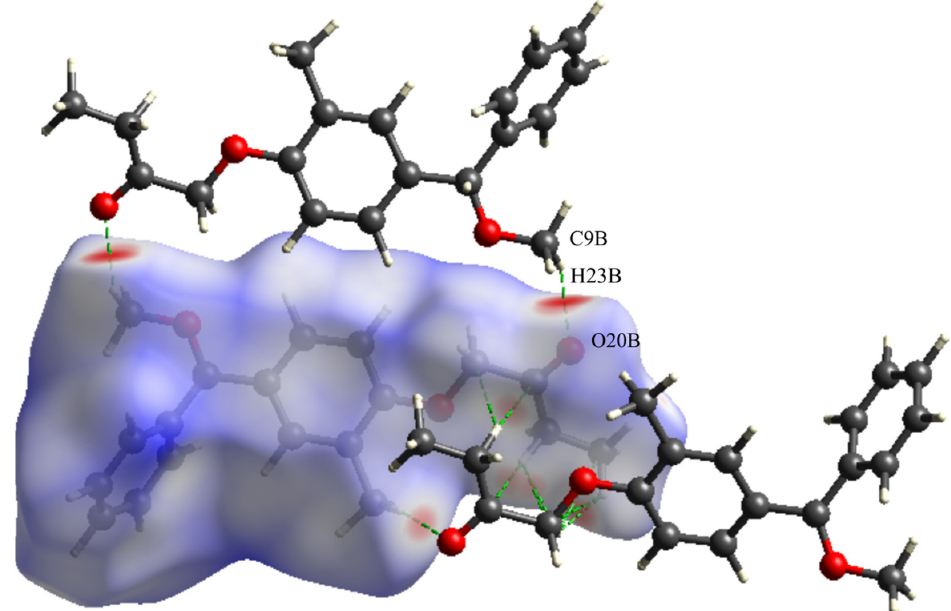
Figure 7. Hirshfeld surface mapped with d norm .